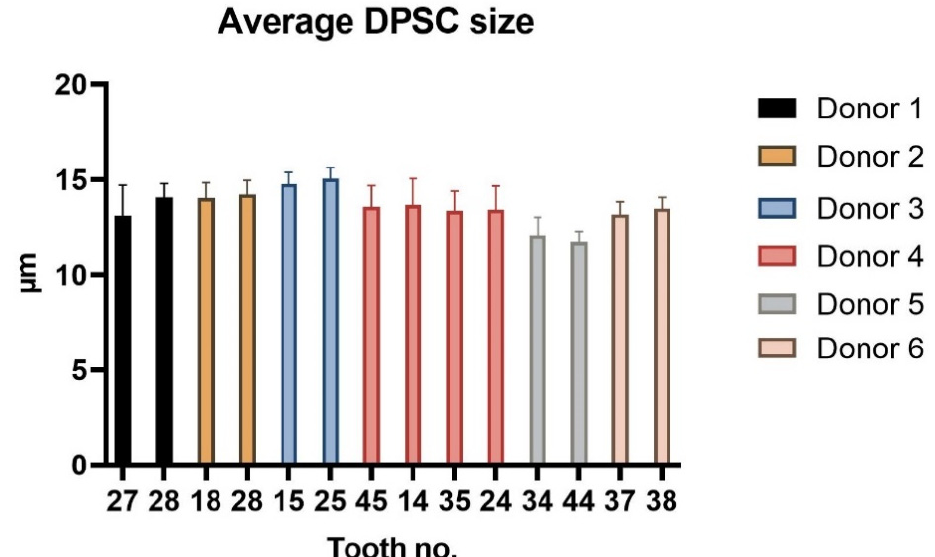
Figure 3. The average cell sizes of all paired DPSC lineages in µ m during entire cultivation. Data are presented as a mean, and SD plotted as error bars. The statistical significance was calculated using a paired t -test; no comparison was statistically significant.